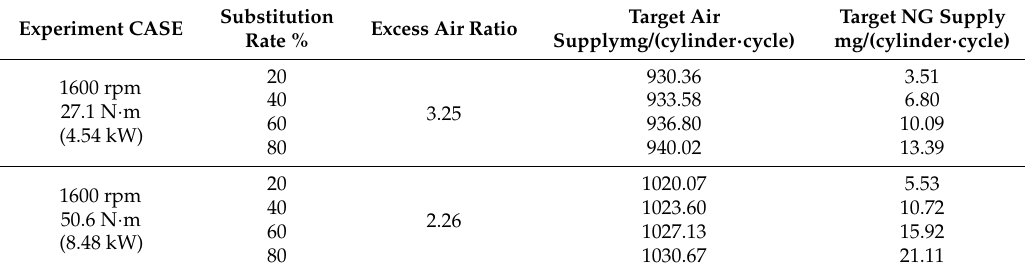
Table 5. Target air supply and NG supply.